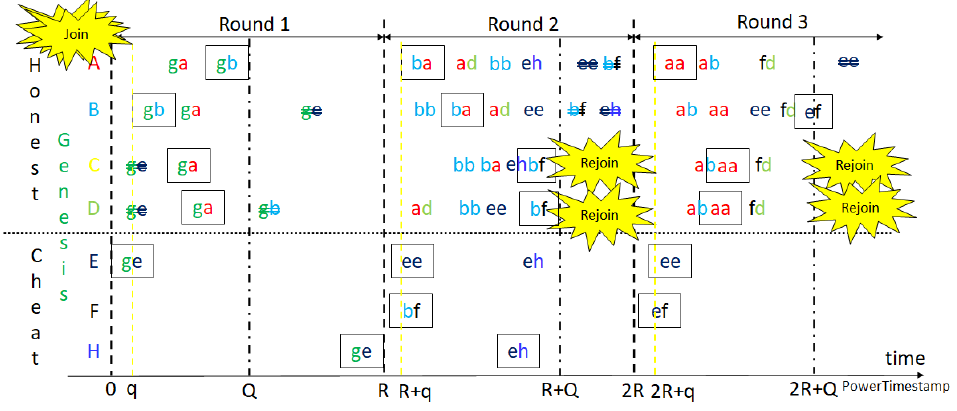
Figure 9. GPoW mining with all in one partition.